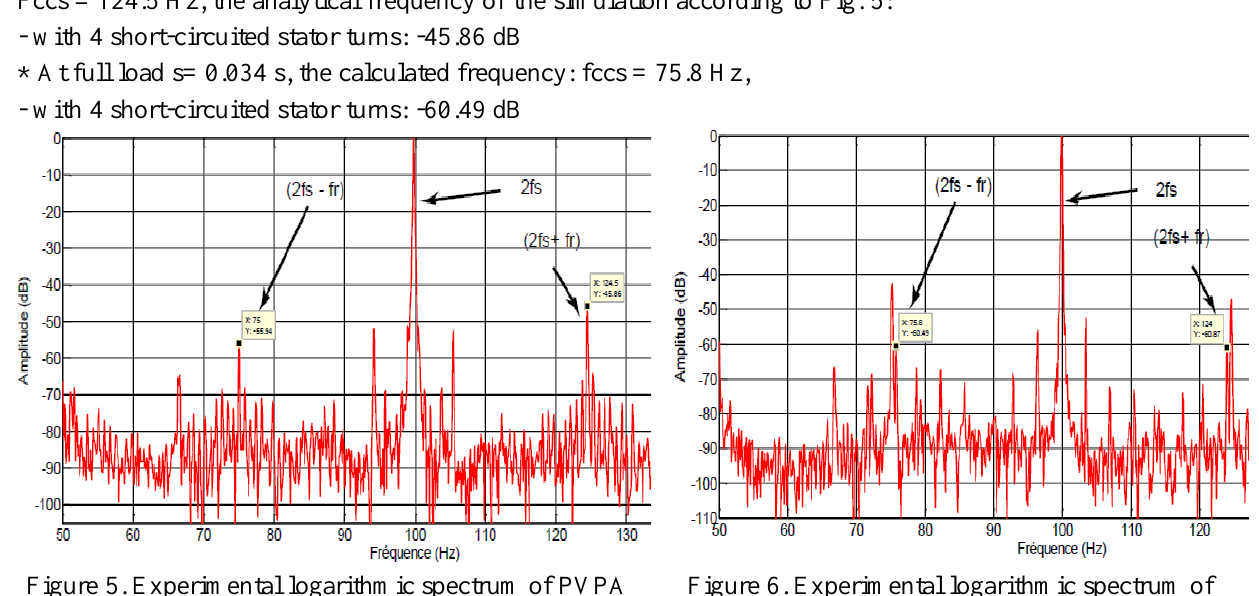
Figure 5. Experimental logarithmic spectrum of PVPA of a motor with 4 short-circuited stator turns at low load